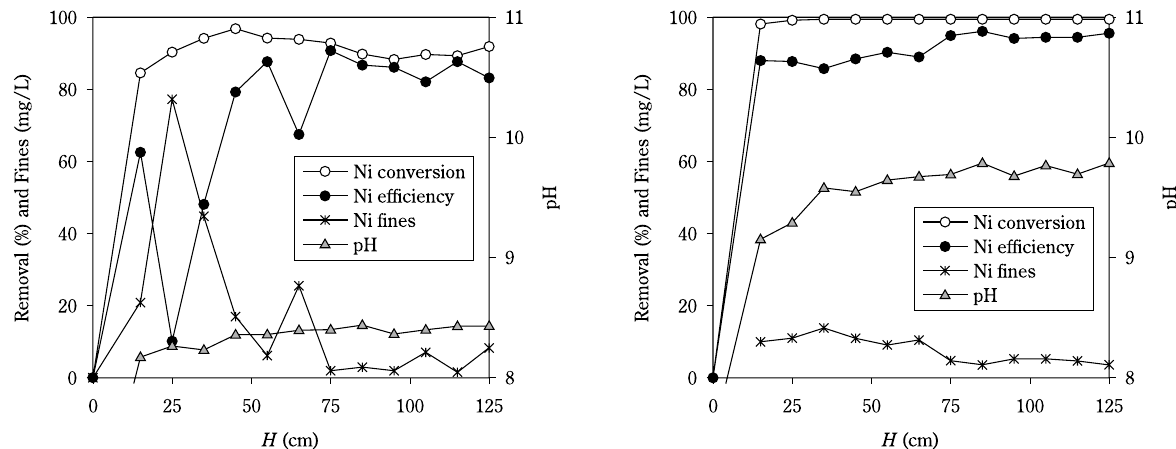
Fig. 3 Change in conversion, efficiency and fines concentration with reactor height for 2FP (left) and 6FP (right).